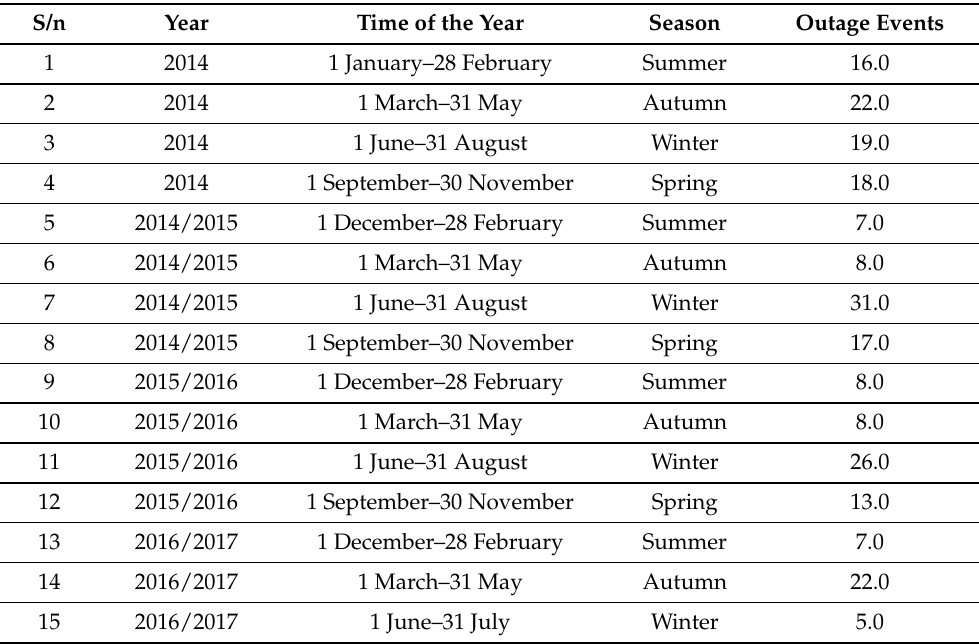
Table 5. System failure target